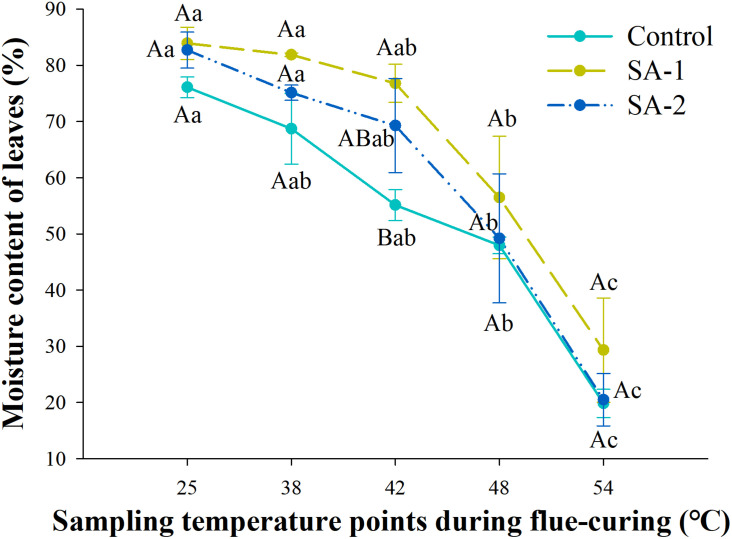
Change of moisture content during bulk curing of flue-cured tobacco with different salicylic acid concentrations. Different capital letters indicate significant differences between treatments at the same stage (P < 0.05). Different lowercase letters indicate significant differences between the same treatments at different curing stages. Data are presented as means ± standard error (n = 3).